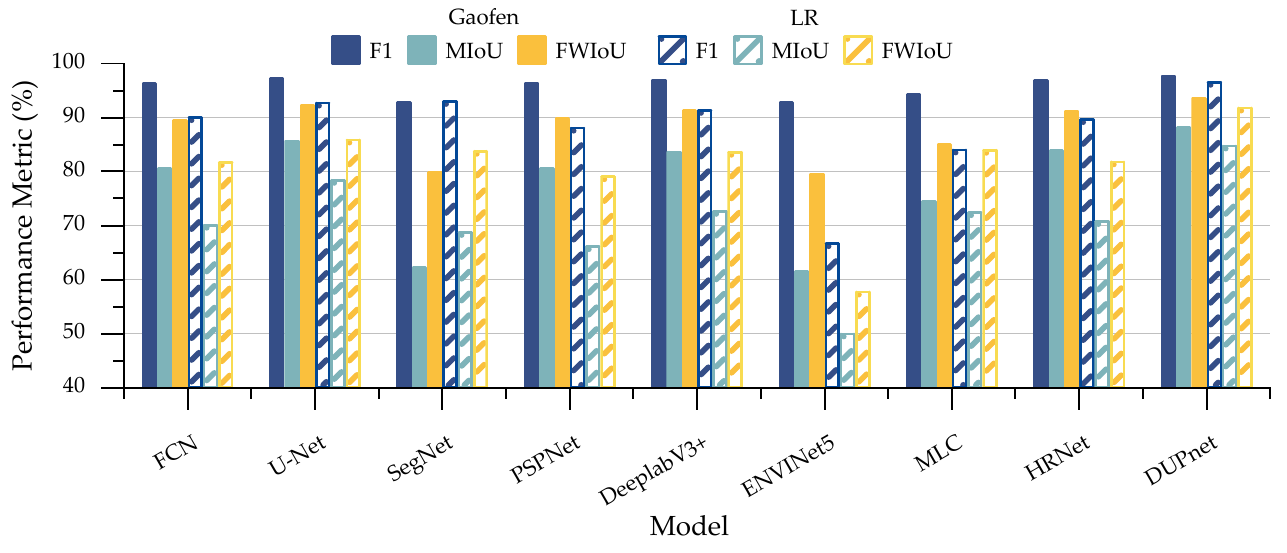
Figure 10. The histogram of quantitative comparison of different models in terms of F1, MIoU, and FWIoU (%) on the 2020 Gaofen challenge water body segmentation dataset and the LR dataset. Table 7. Comparison of spatial complexity and time with the latest models on the LR dataset.